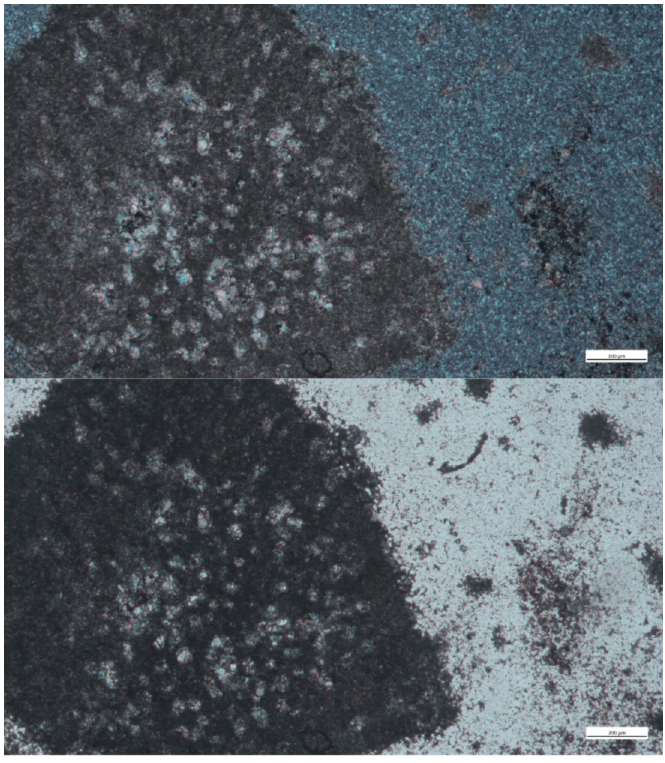
Fig 20. A concentration of foraminifera in a Turonian Bi’na sample, in cross polars (above) and in plain polars (below).